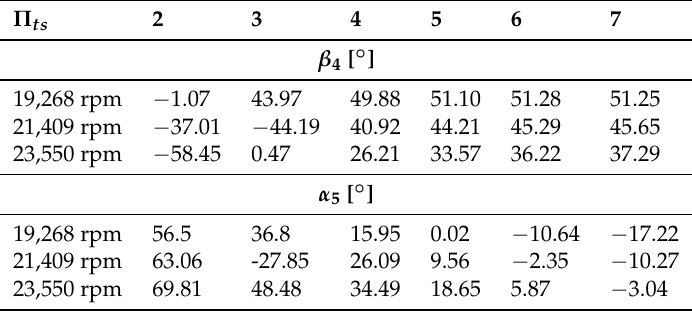
Table 10. Variation of relative flow angle at rotor inlet and absolute flow angle at rotor outlet at off-design